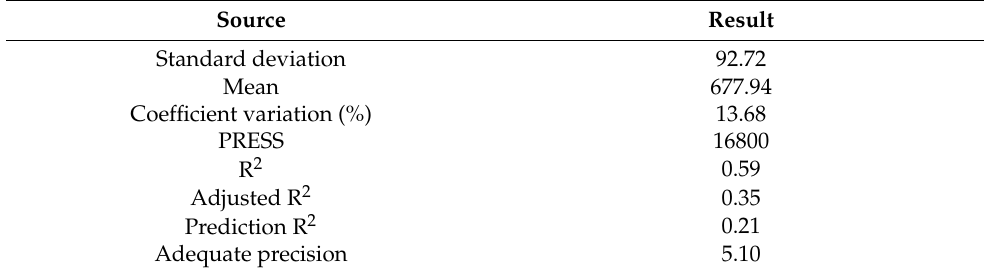
Table 9. Model reliability analysis of adsorption capacity